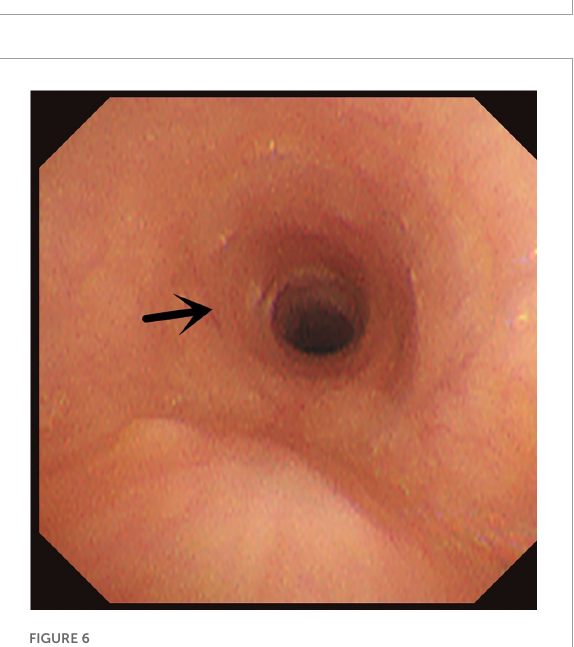
FIGURE6 Congenital annular constriction of trachea. Arrow indicates congenital annular constriction of